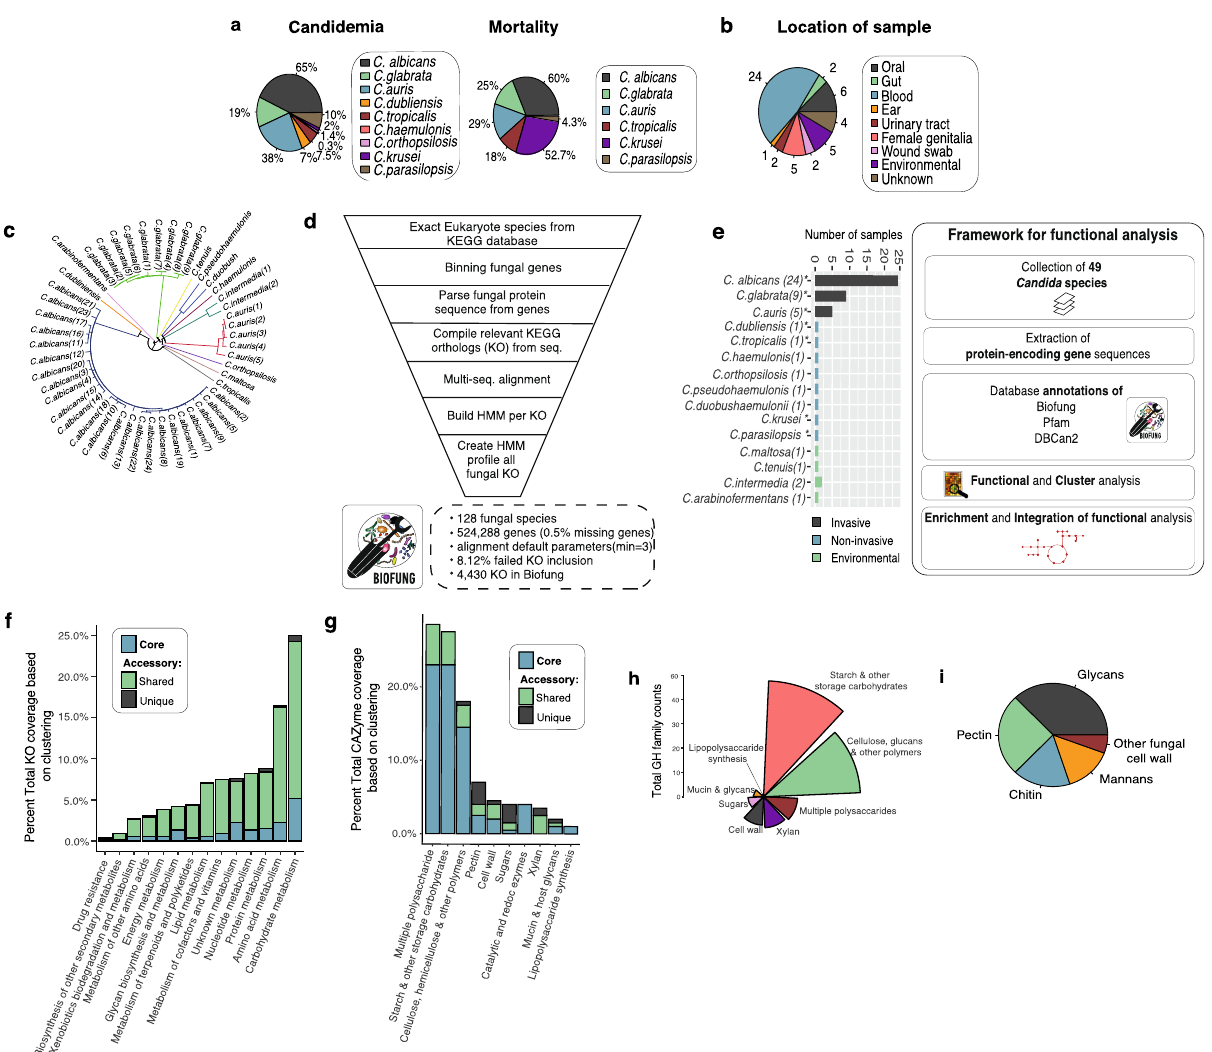
Fig. 1 Exploration of Candida species with BioFung database. a Contribution of individual Candida species to candidemia and mortality . The impact of each species in AGAu species ’ grouping is attributed in this study (literature-based) 16 – 18,20,152 . b Candida strain characterisation . Coverage of Candida sample population per species available with the categorisation of species pro fi led. Numbers around the pie chart signify the number of strain representation in each location. (Supplementary Data 3 for more information about strains and Supplementary Figure 1a for the global representation of Candida strains). c Genome-based phylogenetic tree . The phylogenetic tree was constructed based on average nucleotide identity (ANI) between all strains revealing evolutionary differences across strains (colour coordinated) and indicating distinct metabolic capabilities. See Supplementary Fig. 1b for quality